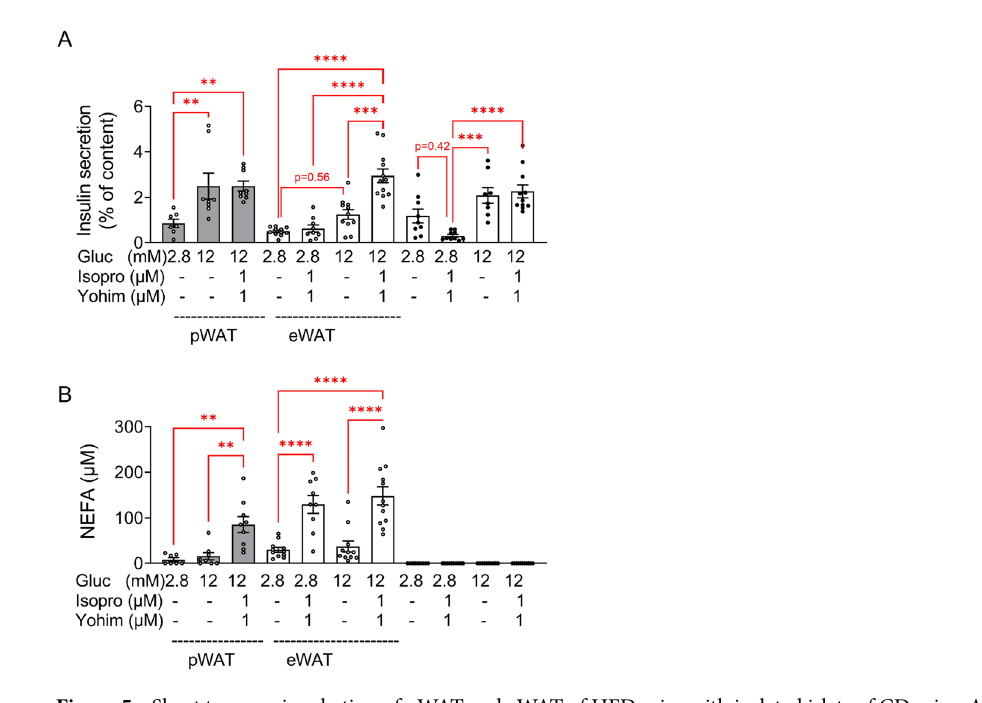
Figure 5. Short term co-incubation of pWAT and eWAT of HFD mice with isolated islets of CD mice. Adipose tissue was preincubated and islets were isolated, cultured overnight and co-incubated as described under Material and methods. Glucose (Gluc), isoproterenol (Isopro), yohimbine (Yohim) were added as indicated. ( A ) Insulin and ( B ) NEFA were measured in the supernatant. Results are expressed as means ± SEM of n = 8–12 observations of 3 independent